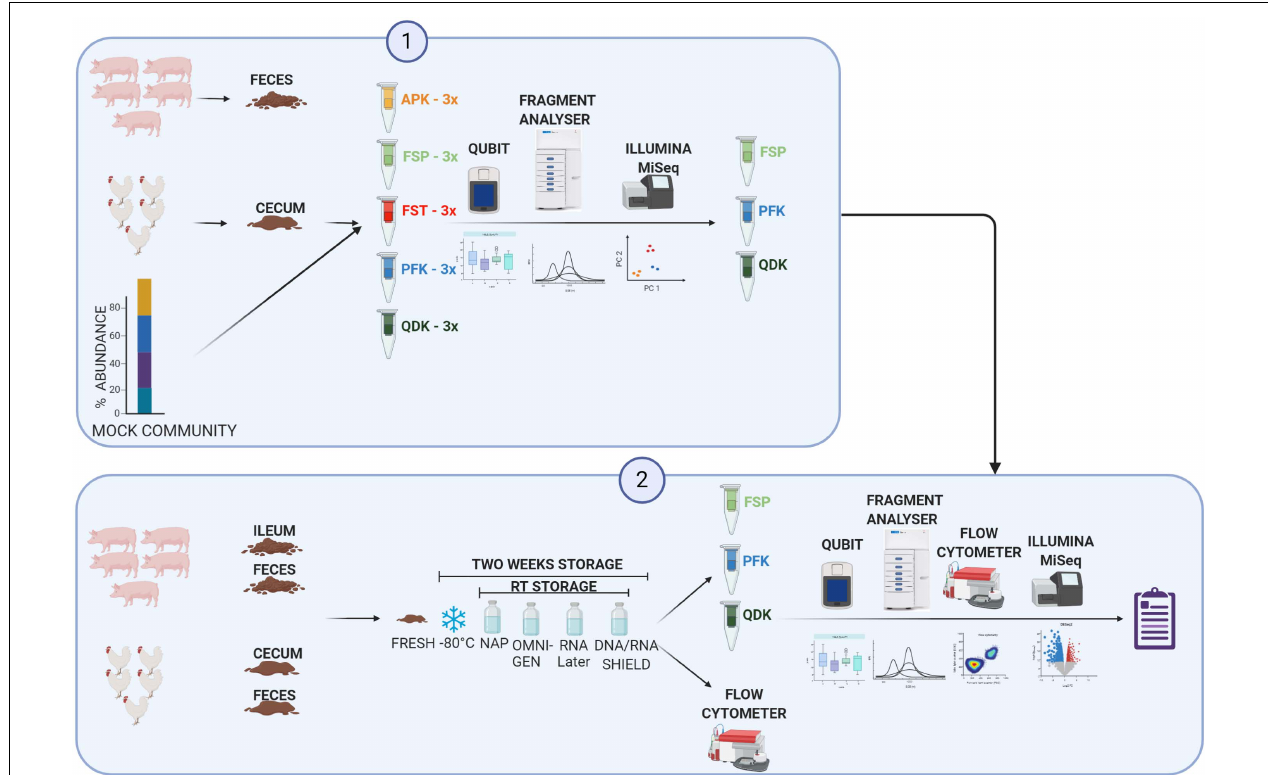
FIGURE 1 | Diagram of experimental design. Phase 1: Gut digesta was collected from five healthy animals and pooled. Along with a standard mock community, pooled gut digesta samples were subjected to DNA extraction using five commonly used DNA extraction kits [the Allprep PowerFecal DNA/RNA Kit (APK), the QIAamp PowerFecal kit (PFK), the MP Biomedicals FastDNA Spin kit (FSP), the QIAamp Fast DNA Stool Mini kit (FST), and the Zymo Quick-DNA Fecal/Soil Microbe Kit (QDK)]. The extracted DNA was subjected to a quality check, integrity analysis, and Illumina sequencing of the 16S rRNA gene. Phase 2: Gut digesta were collected from five healthy animals, pooled, homogenized, and stored in any of the four storage media either at room temperature (RT) or at − 80 ◦ C for 2 weeks. Samples were then subjected to DNA extraction via three DNA extraction kits, which were selected based on the results of Phase 1. Extracted DNA was subjected to a quality check, DNA integrity analysis, and Illumina sequencing of the 16S rRNA gene. The total number of bacteria cells in each sample were quantified using flow cytometry, and the data was used to calculate the quantitative microbiome profiling (QMP) of the samples (details are provided in the “Materials and Methods” section). Created with